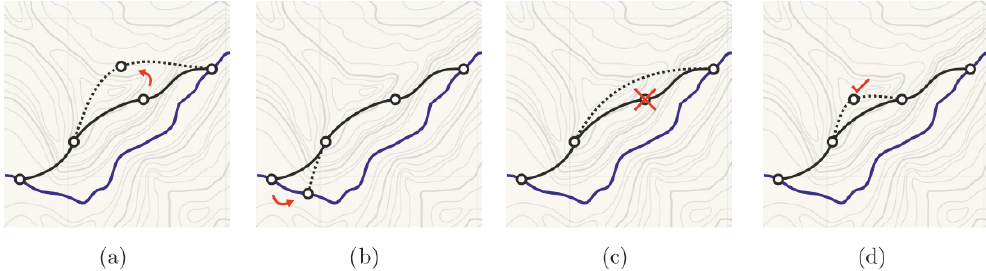
Figure 9. Example of the different actions of the mutation operator on an arbitrary individual: ( a ) displacement of an interior node, ( b ) displacement of an end node, ( c ) elimination of an existing node, and ( d ) creation of a new node. The black continuous and dashed line represents, respectively, the individual before and after the mutation. The blue line represents the river, and the black circles represent the